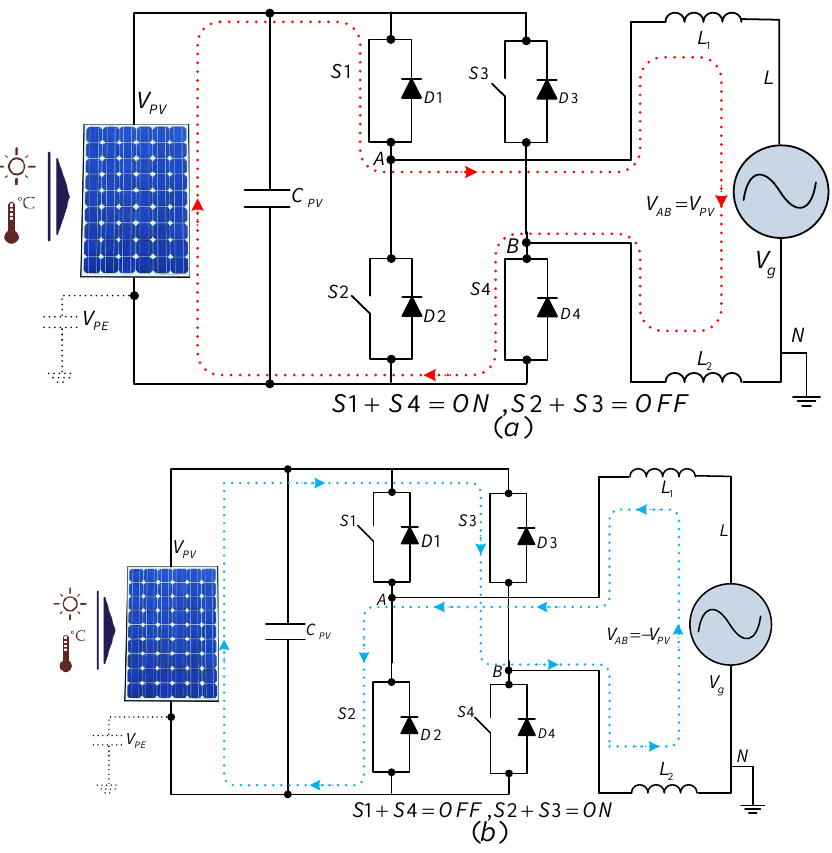
Figure 4. Two-level modulation scheme for FB in case of ( a ) positive cycle and ( b ) negative cycle [29,30].